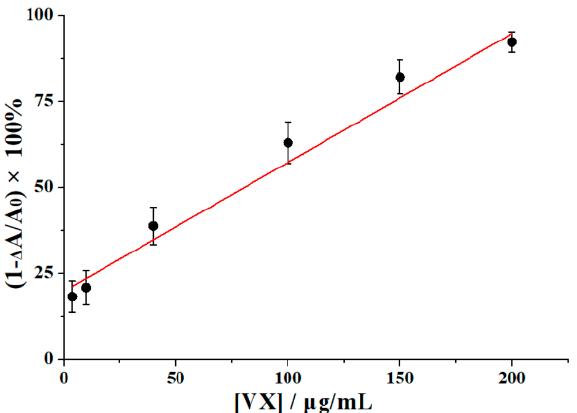
Figure 3. The calibration curve for VX detection using colorimetry.